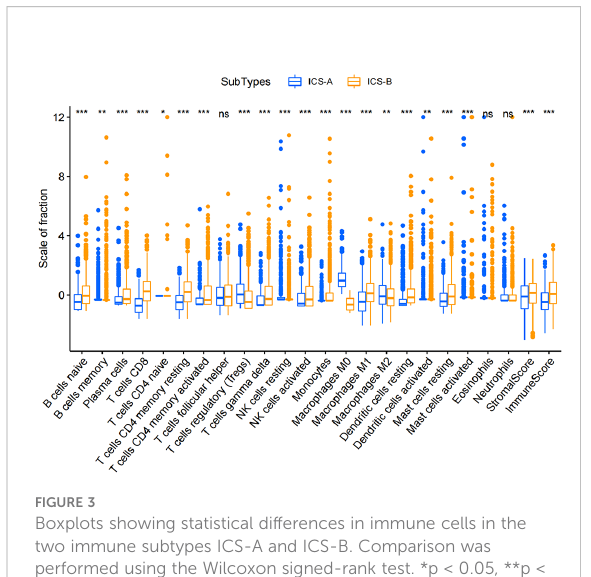
FIGURE 3 Boxplots showing statistical differences in immune cells in the two immune subtypes ICS-A and ICS-B. Comparison was performed using the Wilcoxon signed-rank test. *p < 0.05, **p <